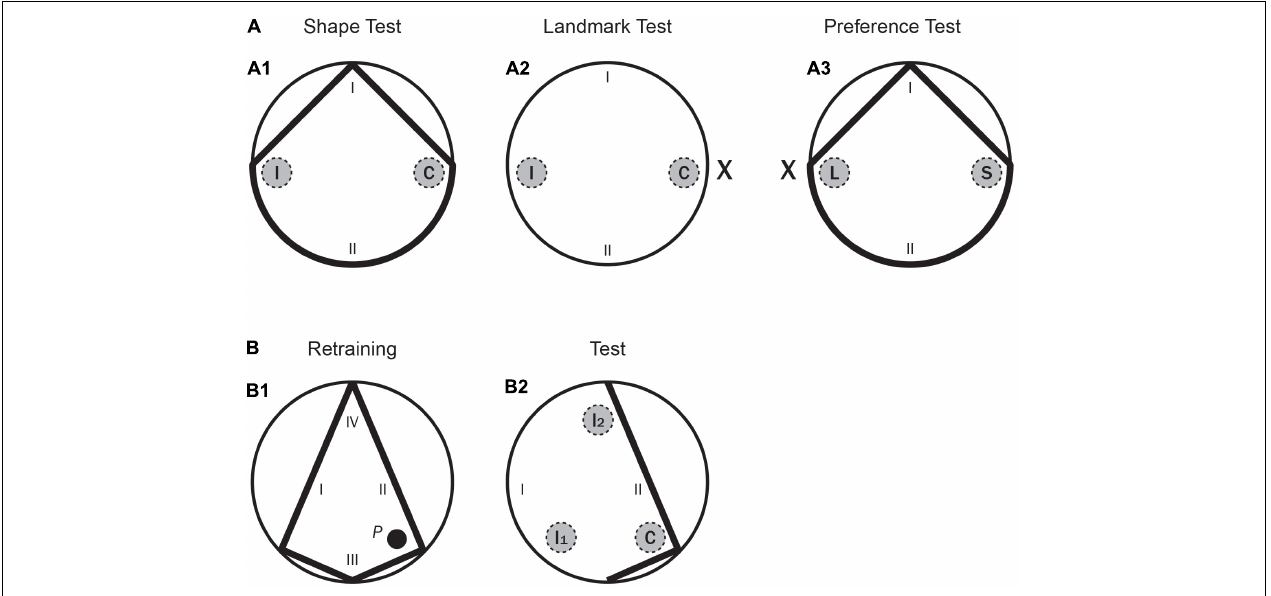
FIGURE 3 | Experiment 2. (A) A schematic representation of the pool shapes, as well as the two recording areas (correct and incorrect, C and I, respectively, for the learning tests; landmark and shape, L and S, respectively, for the conflict test) and the starting positions (I, II) used in the main test trials. (A1) for the Shape test; (A2) for the Landmark test; (A3) for the Preference test. ( B: B1) A schematic representation of the kite shaped pool, as well as the position of the hidden platform ( P ) and the starting positions (I–IV) used in the final Retraining phase. (B2) A schematic representation of part of the kite pool, as well as the three recording areas -correct, incorrect 1 and incorrect 2 (C, I1, and I2, respectively) and the starting positions (I–IV) used in the final test with the Incomplete Kite